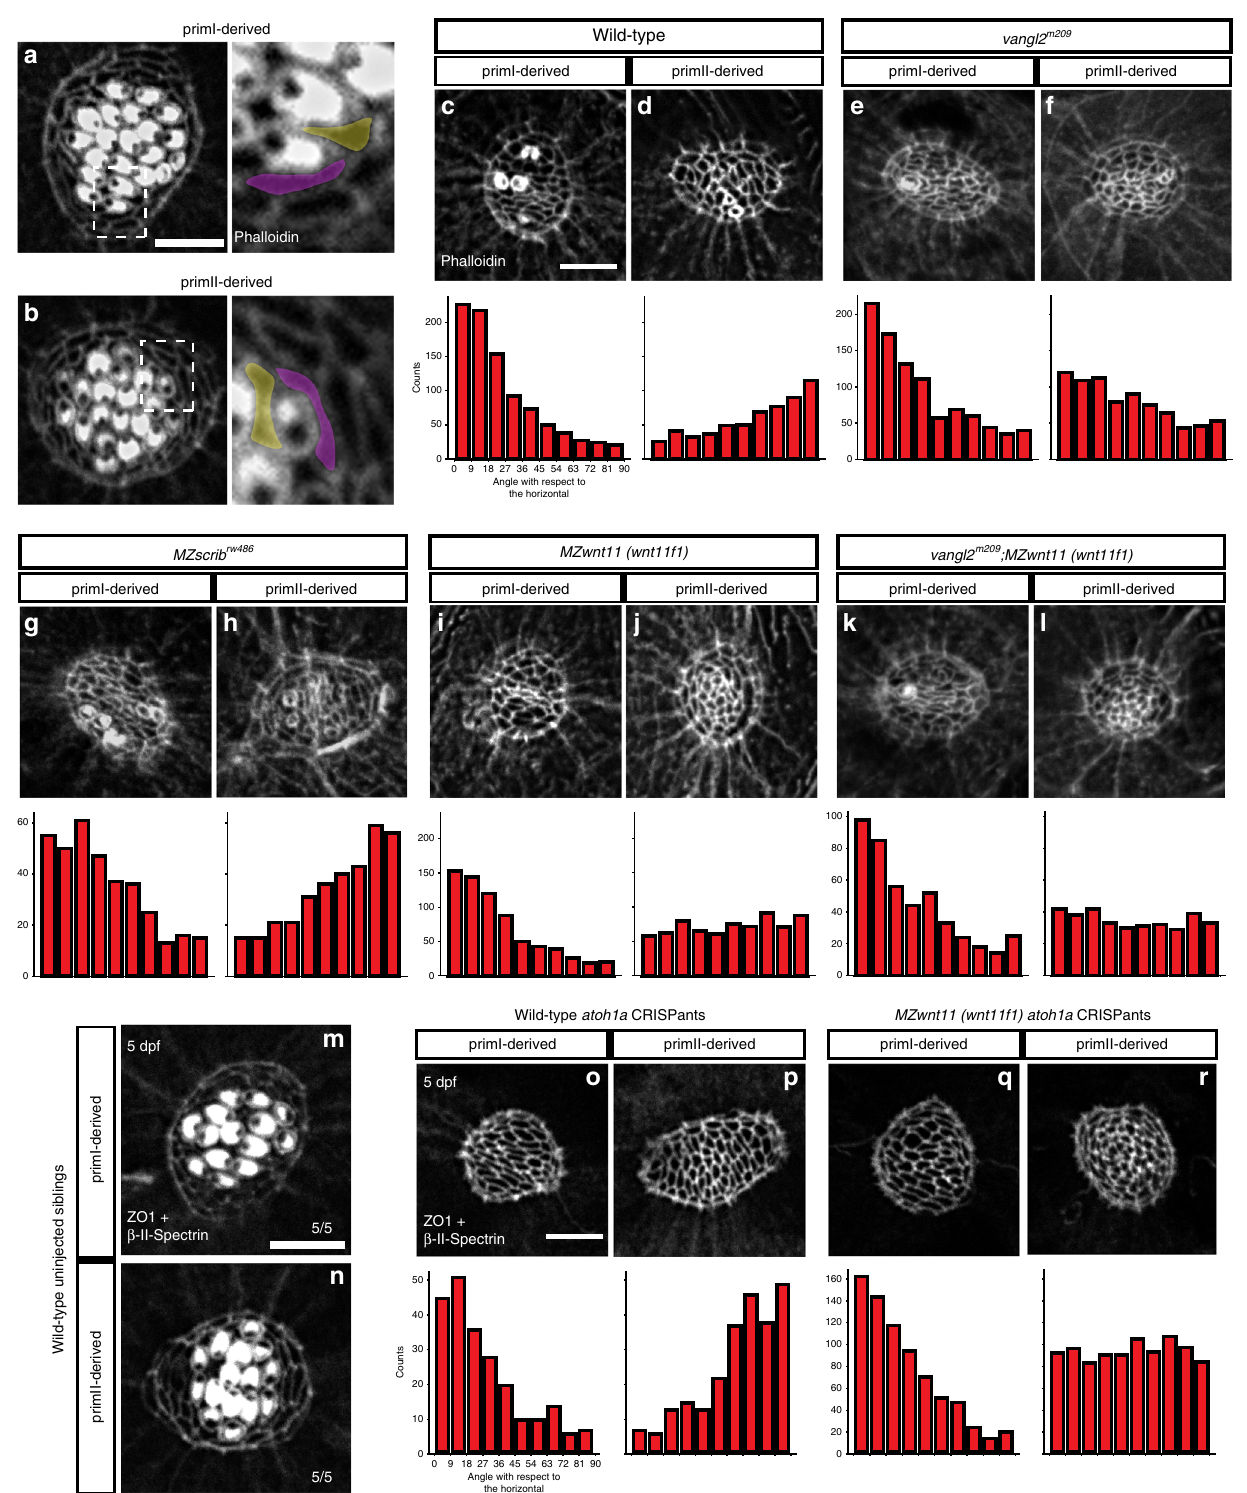
Wnt pathway genes likely act in the premigratory primordium . Because wnt11 (wnt11f1) is not expressed in 5 dpf primII neu- romasts, which show a phenotype in MZwnt11 (wnt11f1) mutants (Figs. 1 and 5), we hypothesized that wnt11 (wnt11f1) might be required earlier in lateral line development to establish hair cell orientation. We tested if Wnt pathway members are expressed in primII or in adjacent tissues during migration or placode speci- fi cation stages. At 50 hpf, while primII is migrating and has not